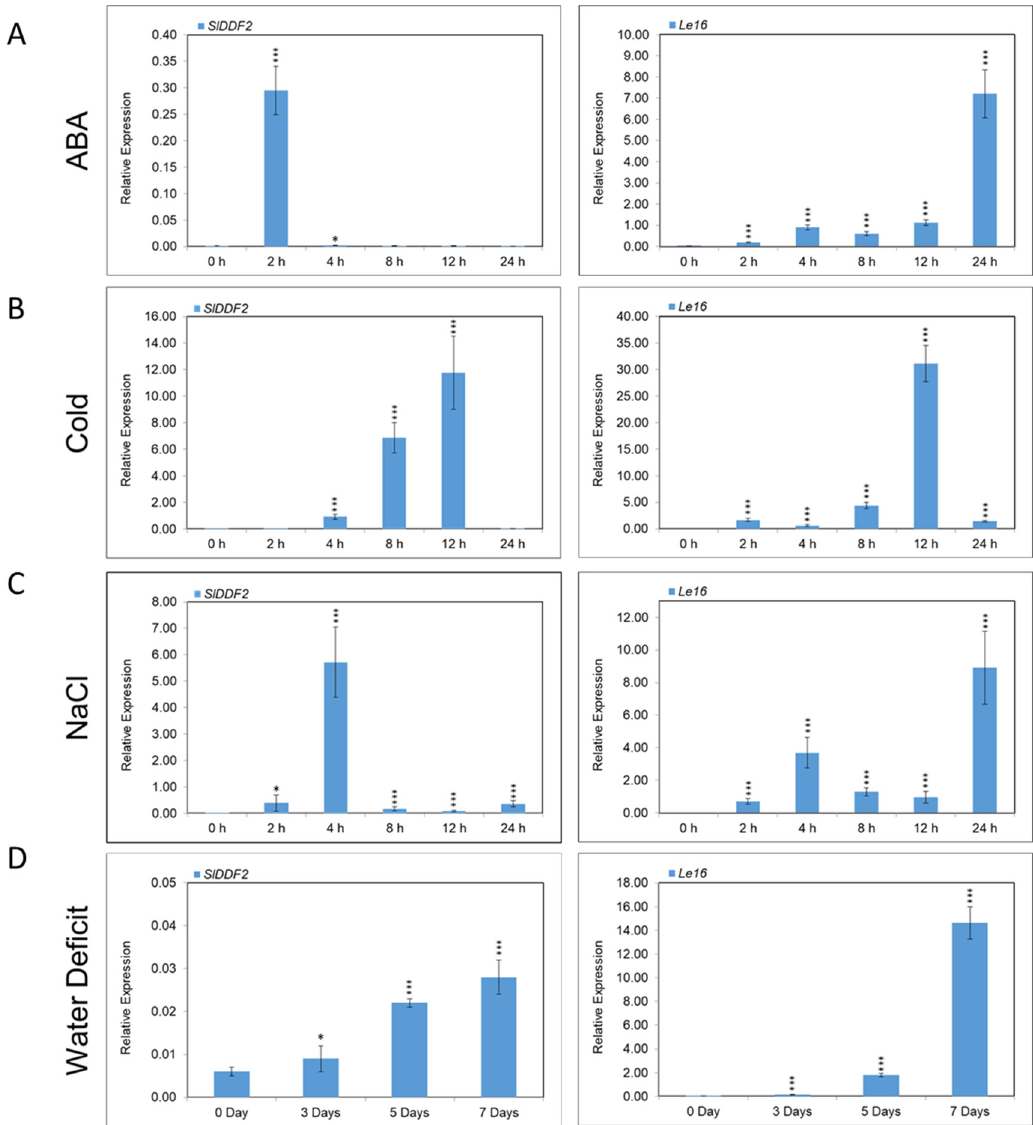
Figure 2. Relative gene expression analysis of SlDDF2 and Le16 in response to ( A ) ABA, ( B ) cold, ( C ) NaCl, and ( D ) water deficit treatments. MM plants were compared to untreated plants (con- trol). The stress-responsive Le16 ( Solyc10g075090 ) gene was included as a control. Values are the means ± SD. of six replicates. Relative expressions are significantly different from those at zero time at different levels: * p < 0.05, *** p < 0.001.